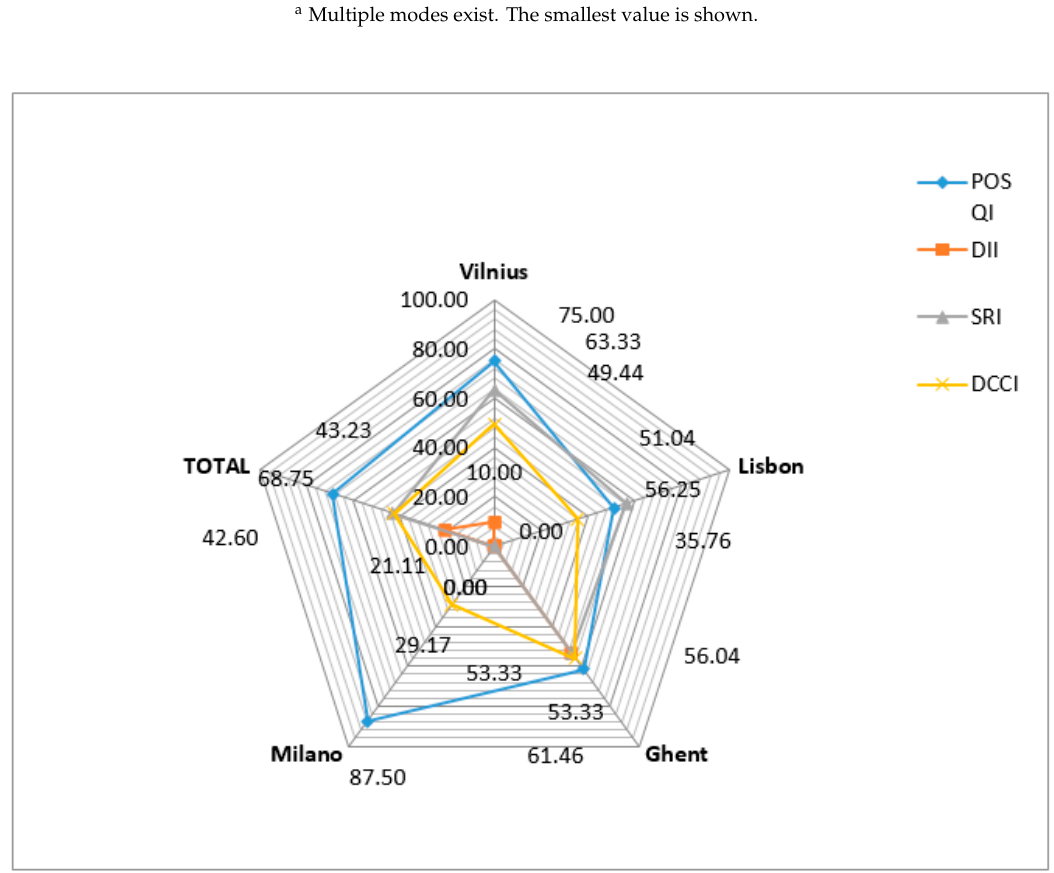
Figure 1. Graphical comparative analysis of four Living Labs according POS Quality Index, Digital Inclusiveness Index, Social Responsiveness Index and Digital Co-Creation Index.